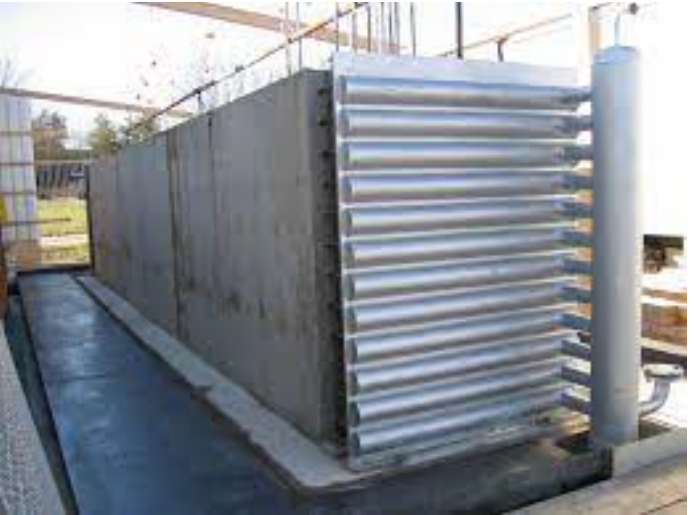
Figure 1. DLR concrete storage concept. Reprinted/adapted with permission from Ref. [9]. 2009, American Society of Mechanical Engineers.